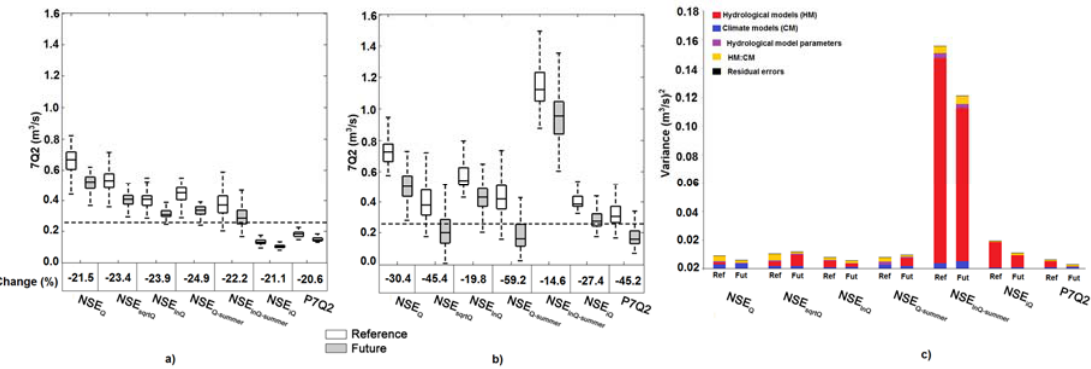
Figure 6. Uncertainties for the 7Q2 indices for the Cowansville sub-watershed related to the climate model structure for the ( a ) GR4J; and ( b ) SWAT model; and ( c ) comparison of 7Q2 index variance for each source of uncertainty in reference (Ref) and future (Fut) periods for each objective function.